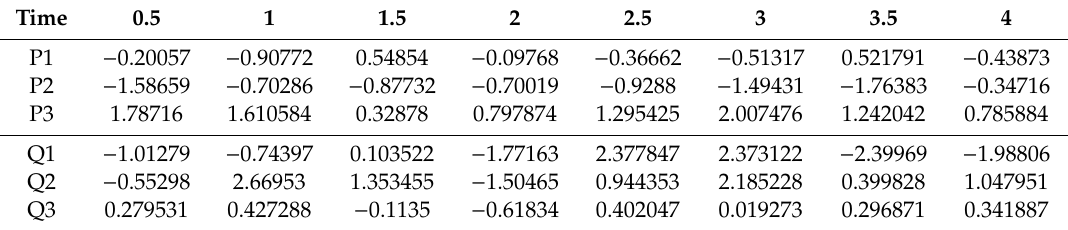
Table 2. Active and reactive command value of each port in the first 4 h.